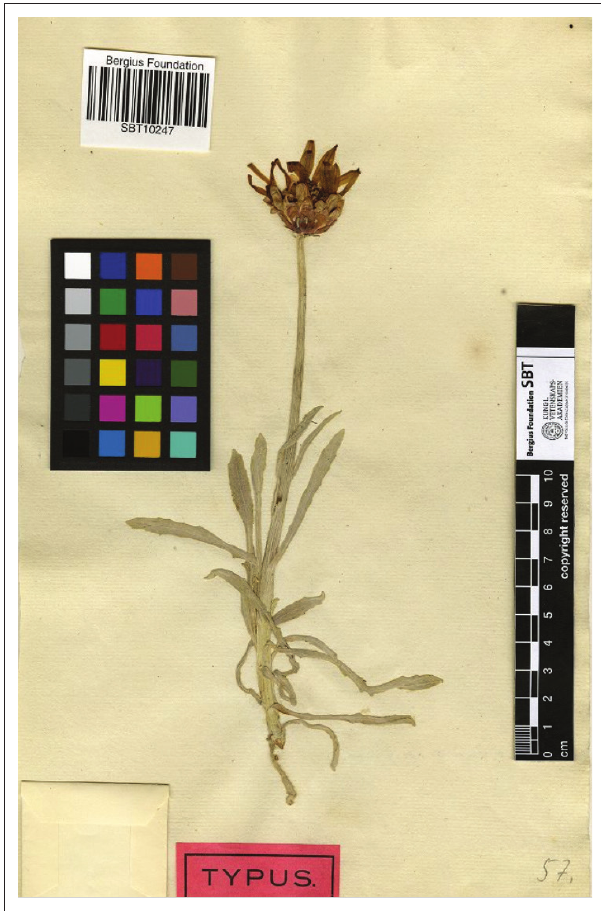
FIGURE 4: Lectotype of Arctotis decumbens Thunb. (UPS-THUNB